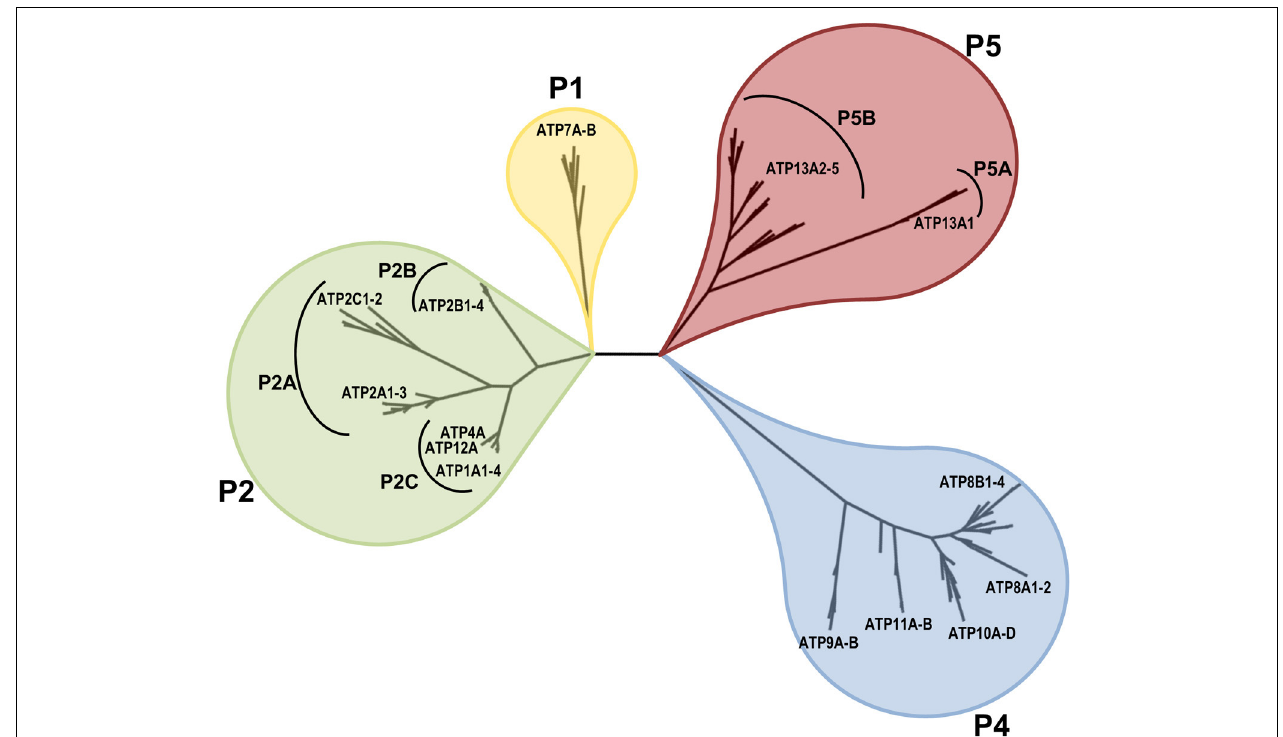
FIGURE 1 | Phyologenetic tree of the human P-type ATPases. Phylogenetic tree based on the core protein sequences of 137 animal homologues of the 36 human P-type ATPase isoforms. ATP13A2 homologues were obtained from the database Homologene http://www. ncbi.nlm.nih.gov/homologene. Core protein sequences were generated according to the methodology described in Axelsen and Palmgren